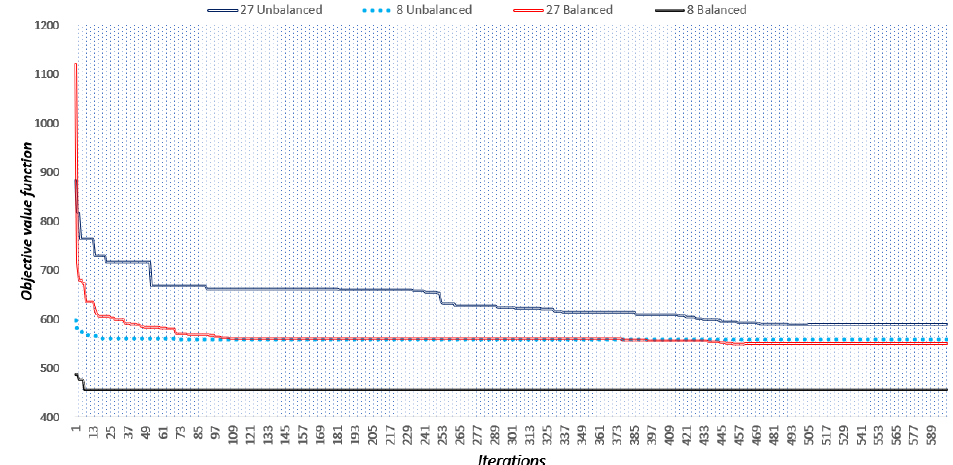
Figure 12. Convergence of the objective function for each test system (note that the objective function was normalized by using a dividing factor of 1000).